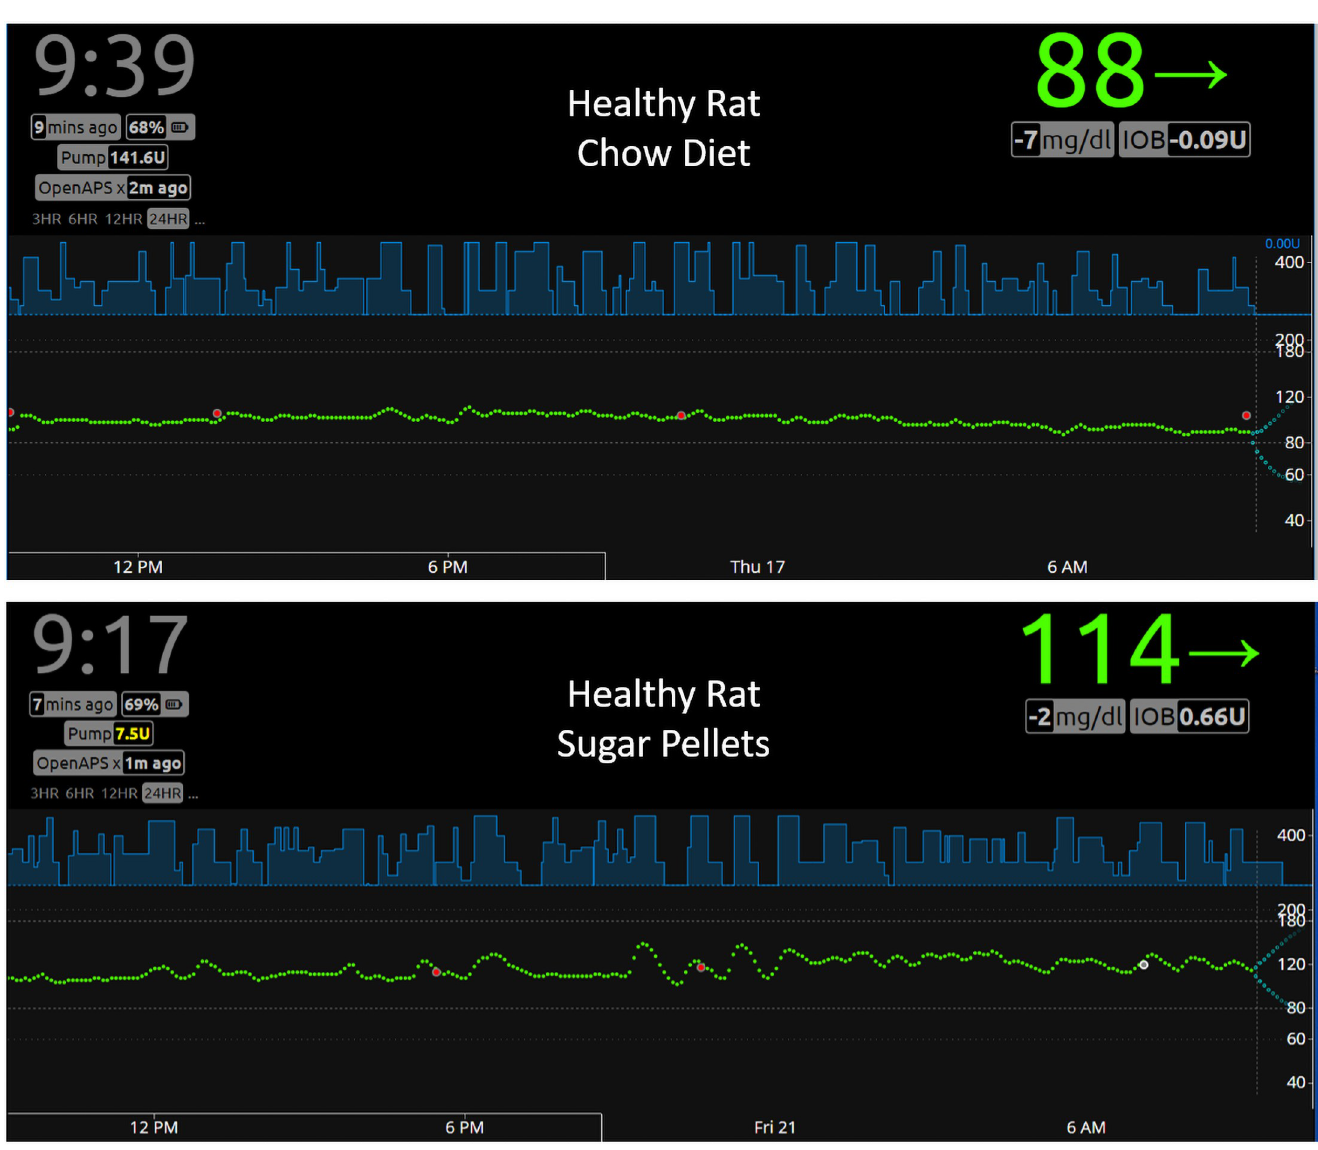
Fig 5. Effects of different diets on BGL and suggested insulin infusion by OpenAPS in healthy rats. Representative Nightscout images of healthy rats fed with chow diet (upper panel) or sugar pellets (lower panel) are shown. A total of 281 closed-loop hours (4 different rats with 8 independent experiments) was collected for healthy rats fed with chow diet. Using the data analysis program, the percent of time in hyper-, hypo- and normal glycemia as well as OpenAPS-suggested insulin infusion rate were calculated as shown in Table 1. A total of 146 closed-loop hours (3 different rats with 5 independent experiments) were collected for diabetic rats fed with sugar pellets (lower